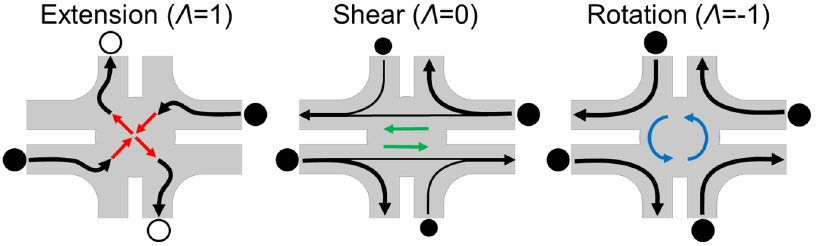
Figure 3. Scheme for generating extensional, shearing, and rotational flows in the fluidic four-roll mill. The black circles indicate the direction and magnitude at which fluid is supplied to (filled circles) or withdrawn from (open circles) the device. The colored arrows represent the nominally generated flow type and black arrows indicate the direction and magnitude of flow rates in the inlet/outlet